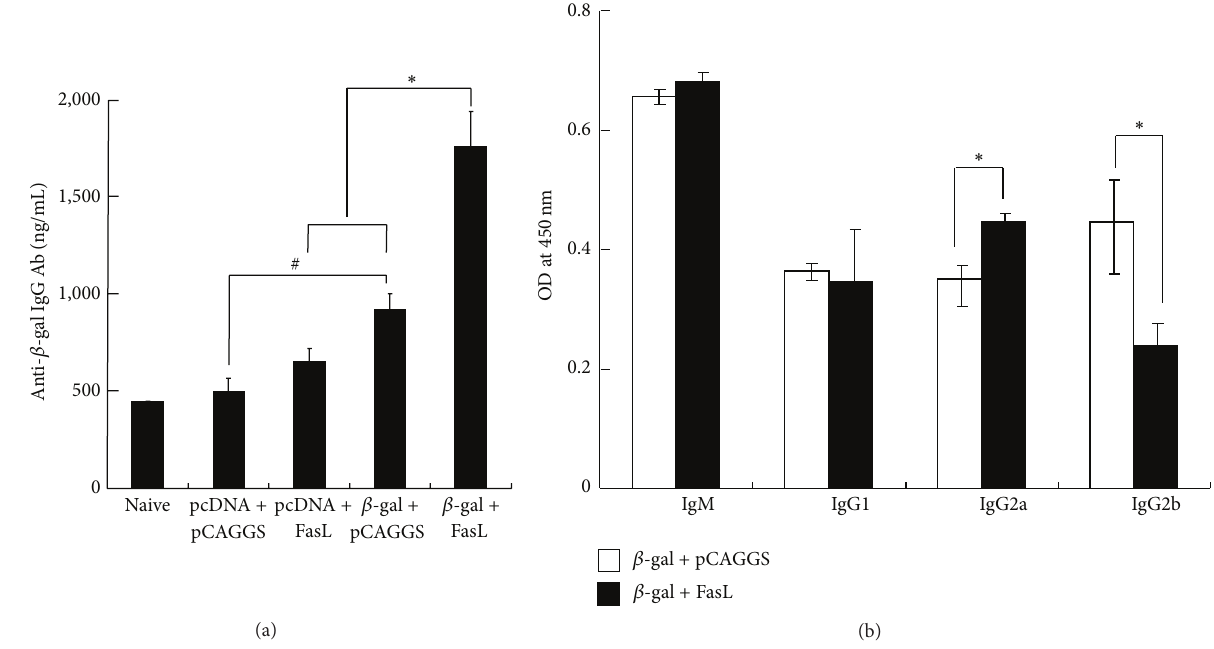
Figure 4: Production of ant- 𝛽 -gal Ab after DNA immunization. BALB/c mice were treated with cardiotoxin followed by DNA immunization, pcDNA3 + pCAGGS, pcDNA3 + pCAGGS/FasL, pcDNA3/ 𝛽 -gal + pCAGGS, or pcDNA3/ 𝛽 -gal + pCAGGS/FasL (50 𝜇 g DNA for each). (a) Concentrations of anti- 𝛽 -gal IgG Ab in the mice 14 days after DNA immunization were measured with an ELISA assay ( 𝑛 = 3 ). (b) Concentrations of Ig subclasses were expressed as an optical density value ( 𝑛 = 3 ). # 𝑃 < 0.05 , ∗ 𝑃 < 0.01